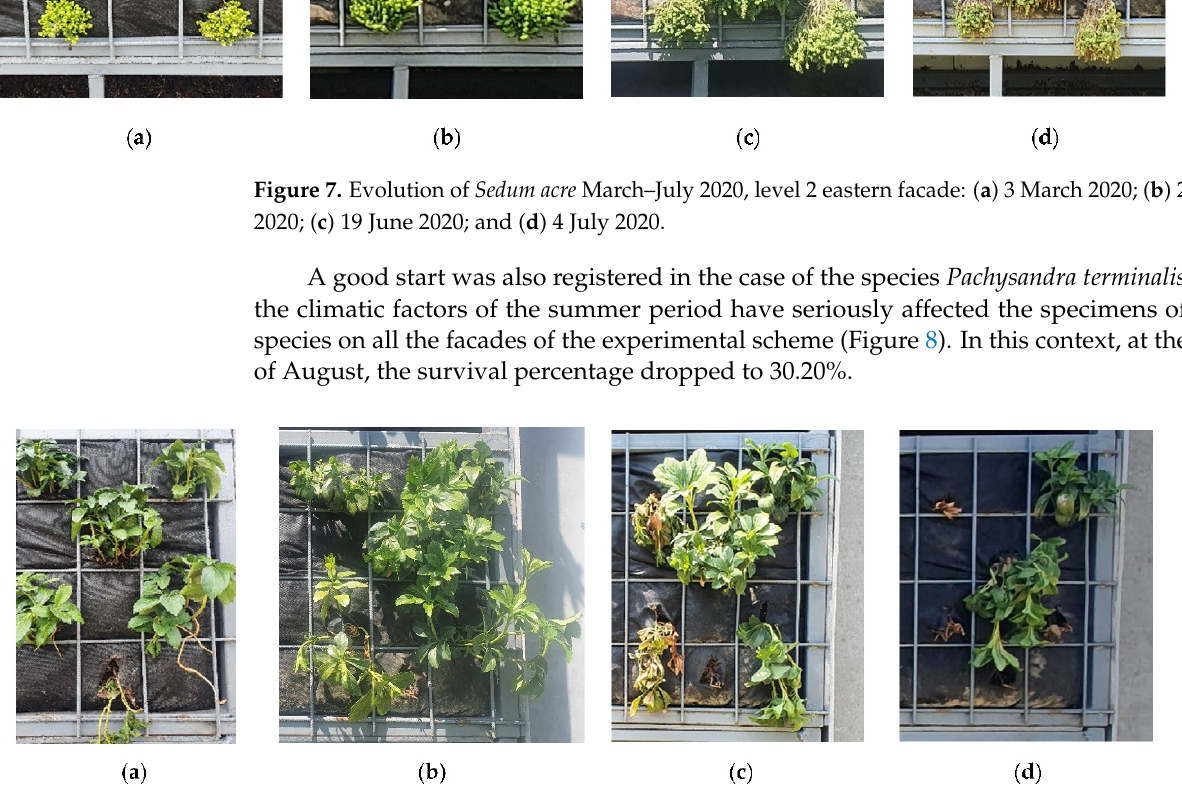
Figure 8. Pachysandra terminalis March–August 2020, level 3 eastern facade: ( a ) 3 March 2020; ( b ) 19